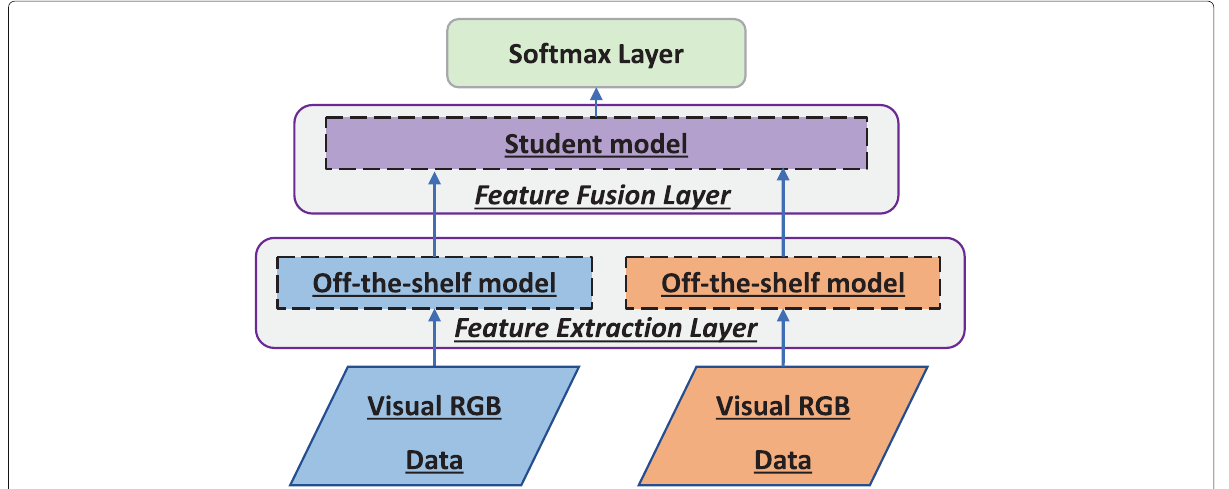
Fig. 1 The proposed architecture consists of three functional layers, thefeatureextractionlayer , thefeaturefusionlayer , and